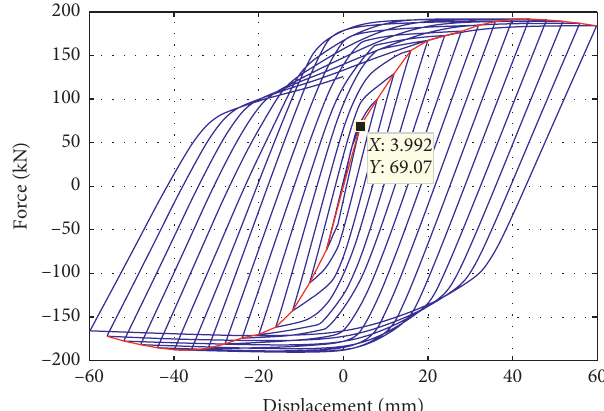
Figure 6: Hysteretic curves and skeleton curves of the frame